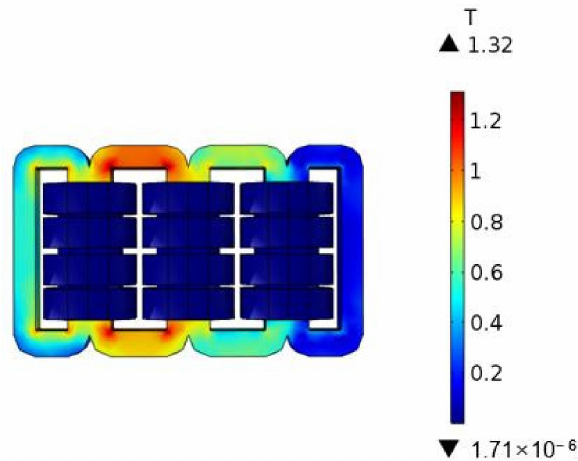
Figure 5. Distribution of core magnetic flux density at 100% rated